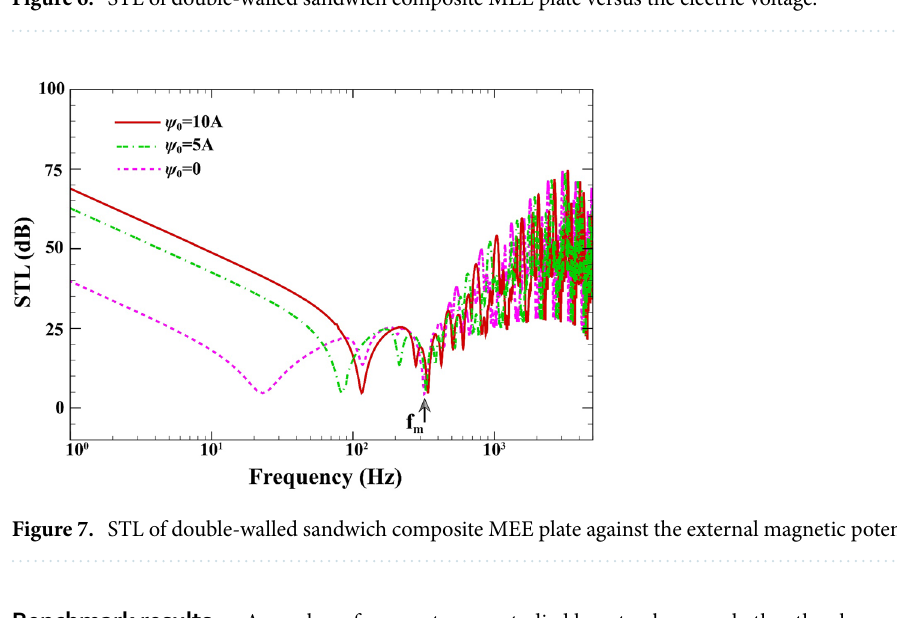
Figure 6. STL of double-walled sandwich composite MEE plate versus the electric voltage.